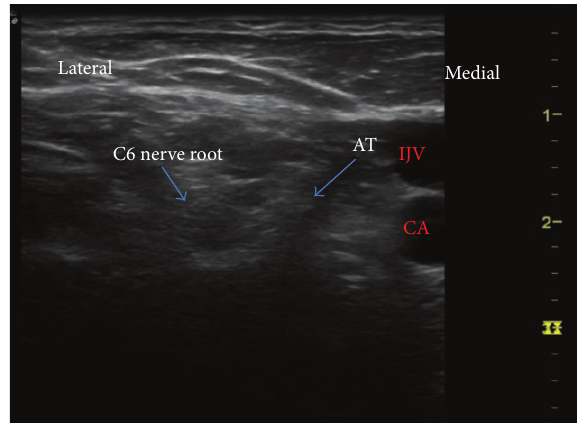
Figure 1: Identification of C6 level. IJV: internal jugular vein, CA: carotid